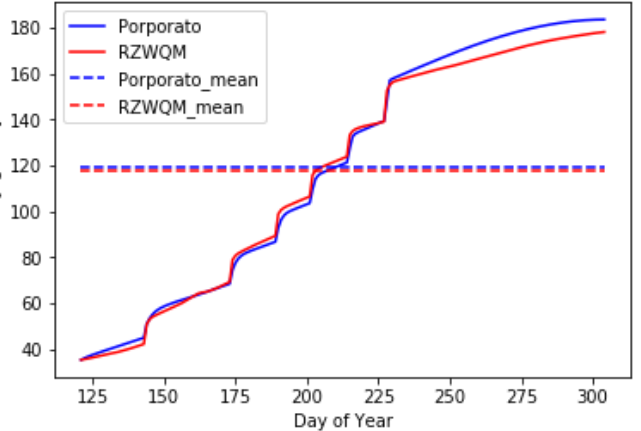
Figure 10. Plot of nitrate concentration by two models for each day of year of the growing